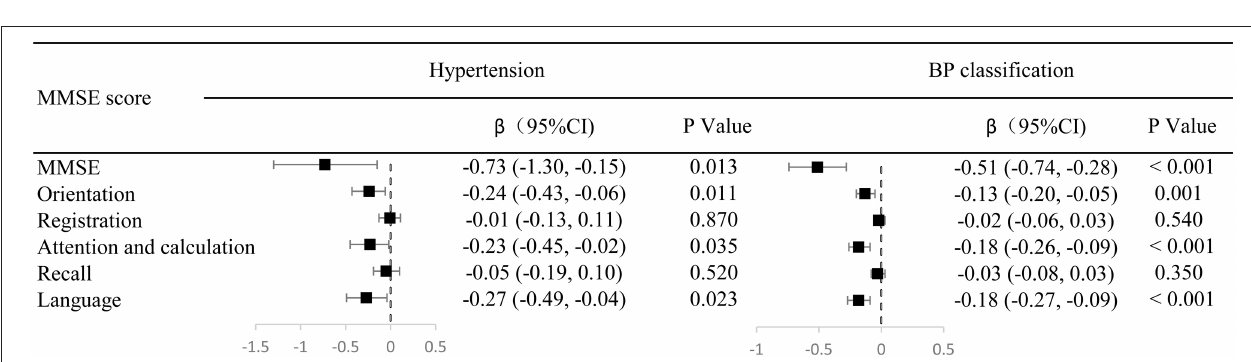
FIGURE 3 | Odd ratios of cognitive function in hypertension and blood pressure grading in multivariate analysis. The hypertension and blood pressure classification were both included in one model, which is mainly adjusted for age group, sex, drinking history, and education. There was a significant association of both hypertension and blood pressure classification with MMSE score ( P < 0.05). In addition, scores for orientation, attention and calculation, and language significantly decreased by 0.24, 0.23, and 0.27 points, respectively, in the hypertension group compared with the non-hypertension group (all P < 0.05). Similarly, compared with the normal blood pressure classification, with each increase in the grade of hypertension, scores for orientation, attention and calculation, and language significantly decreased by 0.13, 0.18, and 0.18 points, respectively, (all P < 0.05). However, registration and recall scores were not associated with hypertension and blood pressure